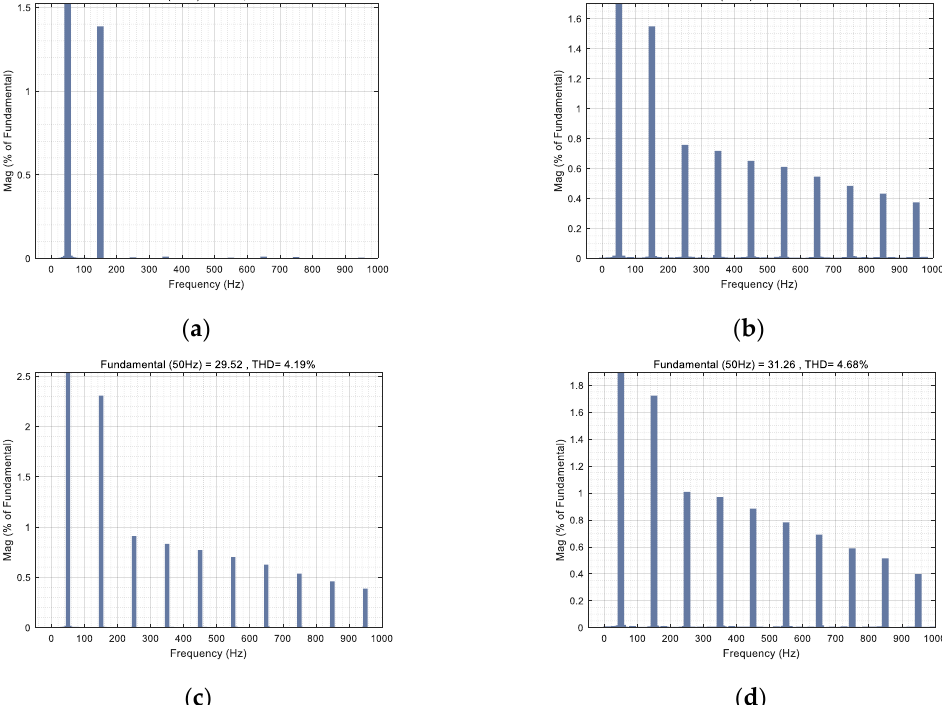
Figure 10. Input current Fourier decomposition; ( a ) H-bridge rectifier; ( b ) Bridgeless rectifier; ( c ) VIENNA rectifier; ( d ) Diode H-bridge boost rectifier.